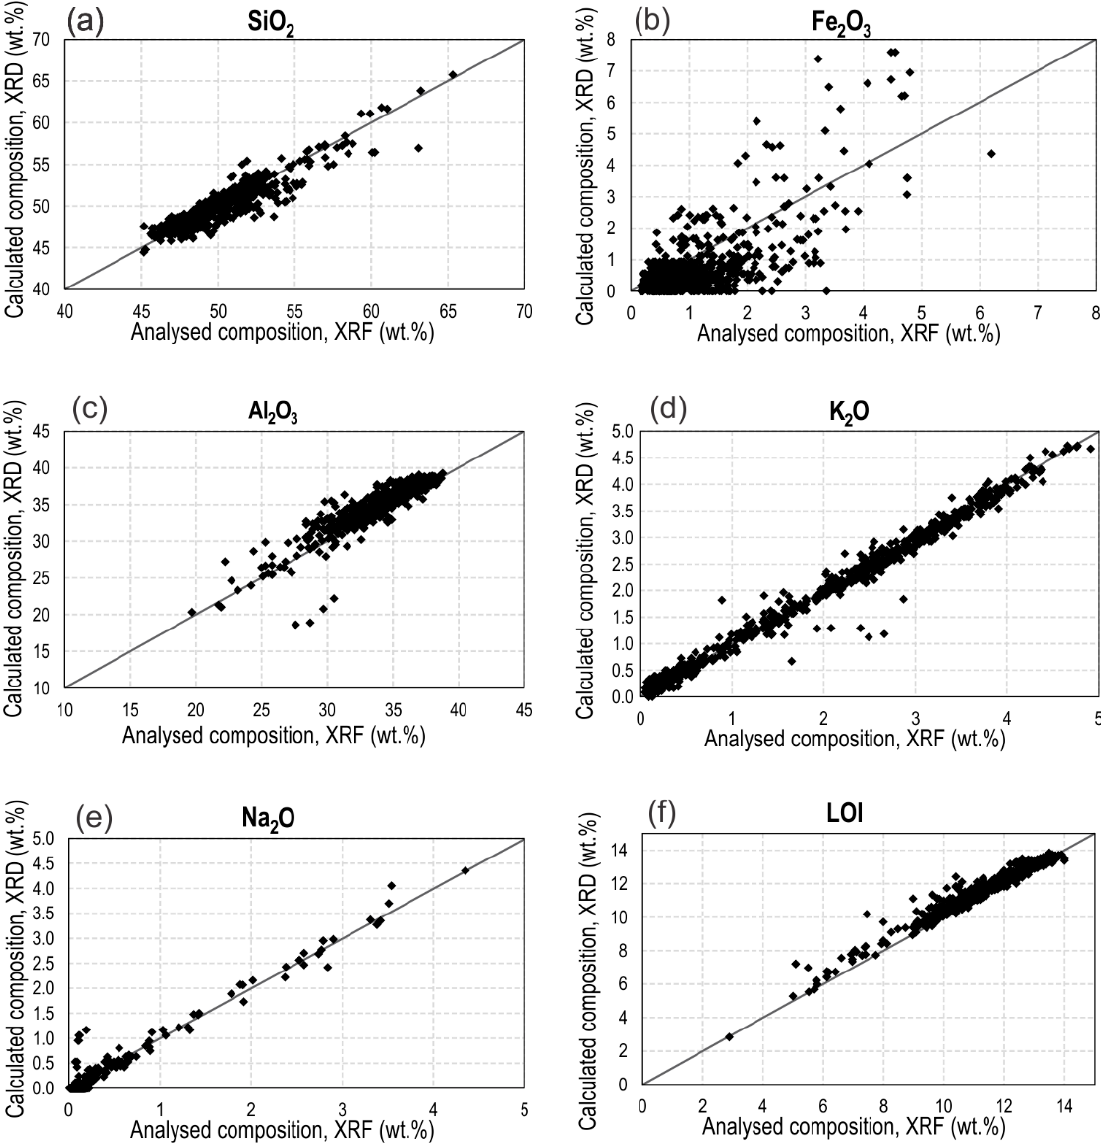
Figure 4. Bulk composition plots for XRF value vs. calculated bulk composition from XRD data for the main components: ( a ) SiO 2 ; ( b ) Fe 2 O 3 ; ( c ) Al 2 O 3 ; ( d ) K 2 O; ( e ) Na 2 O; ( f ) LOI (H 2 O + CO 2 ). The one-to-one line is shown.